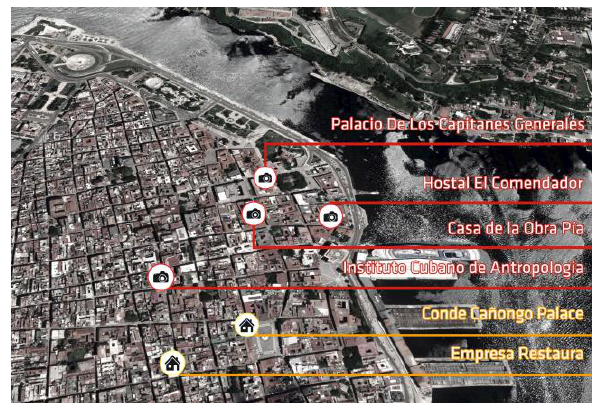
Figure 1. Map of the activities carried out in La Habana Vieja : red stands for photogrammetric acquisitions, yellow for the in- class activities and final seminar locations